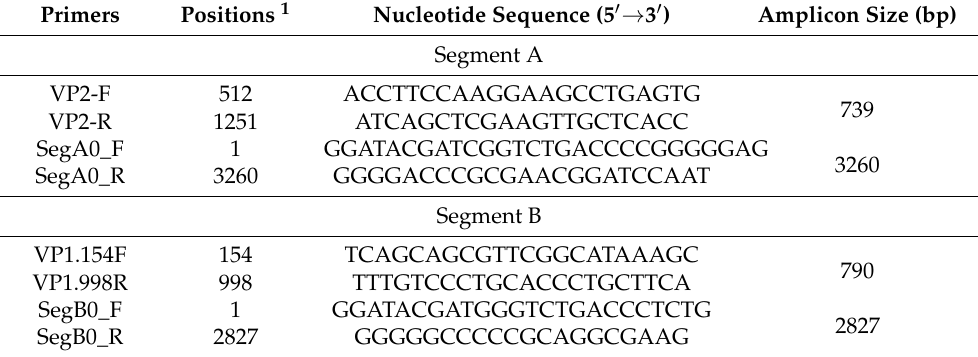
Table 1. Primers used for amplification of IBDV in the